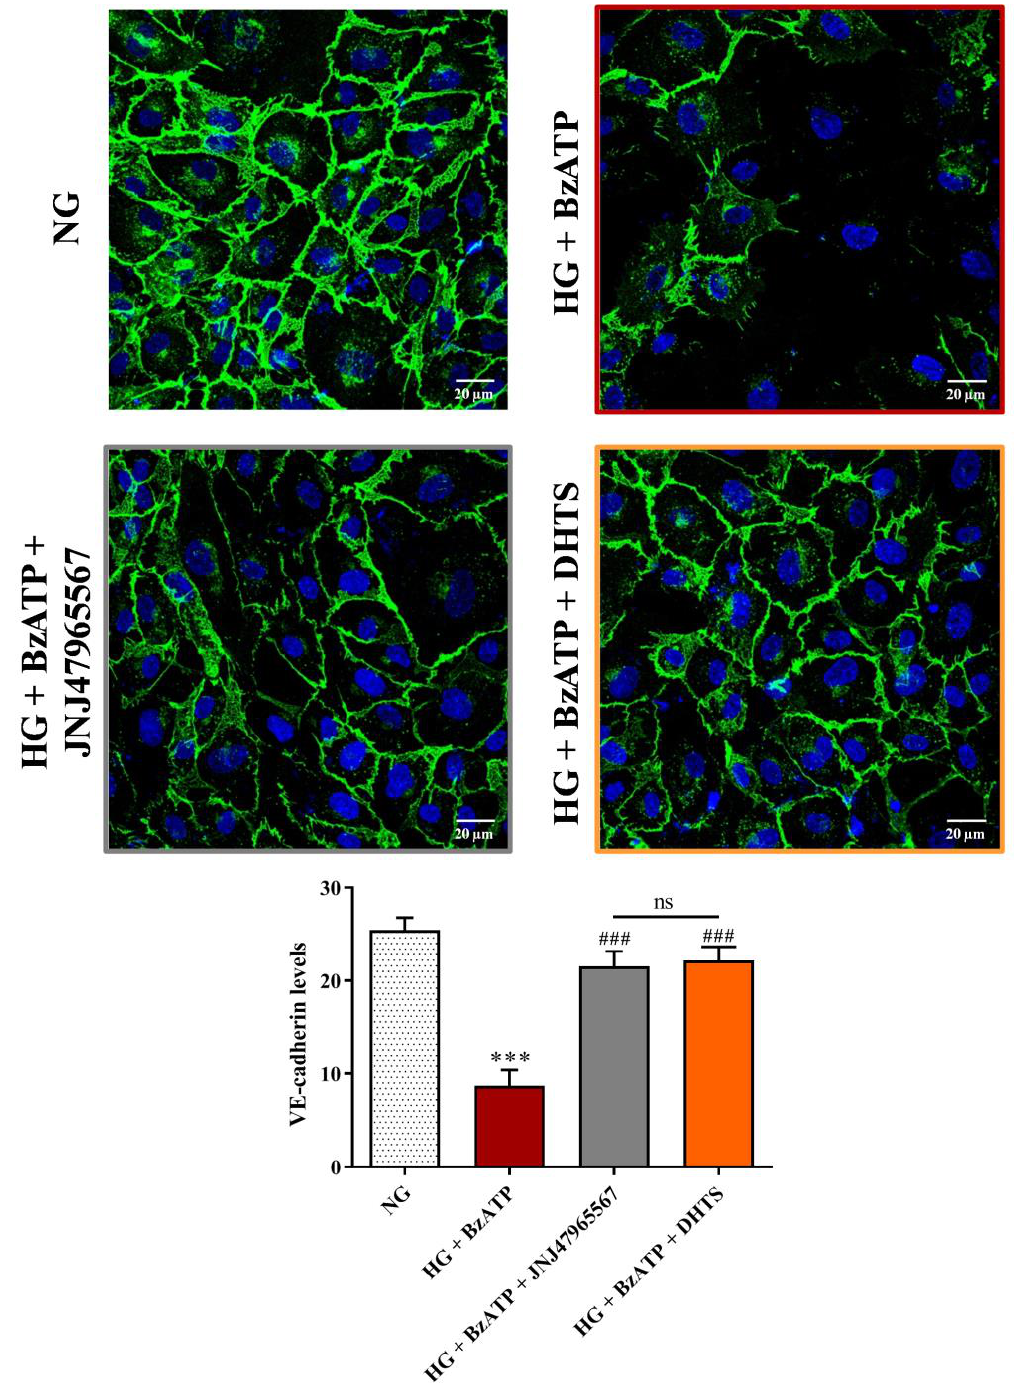
Figure 5. Confocal analysis of VE-cadherin in endothelial cells subjected to normal or high glucose conditions + BzATP, in the absence or in the presence of JNJ47965567 or DHTS, for 48 h. VE-cadherin was labeled with FITC (green) while nuclei were labeled with DAPI (blue). Images for VE-cadherin immunostaining were acquired at 20 × magnification. Scale bar: 20 µ m. NG = normal glucose condition (5 mM). HG = high glucose condition (40 mM). BzATP = 200 µ M. JNJ47965567 = 100 nM. DHTS = 500 nM. The average intensity (AU) of the data from more than 30 cells per coverslip for VE-cadherin under our experimental conditions are shown. Values are reported as means ± SD of three independent experiments. Statistical analysis was performed using one-way ANOVA with Tukey’s post-hoc analysis. *** p < 0.001 vs. NG. ### p < 0.001 vs. HG + BzATP. ns = not